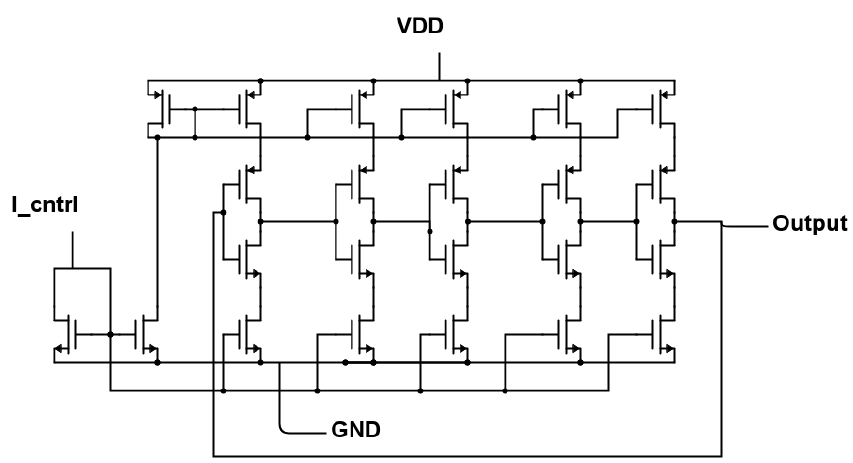
Figure 3. Schematic diagram of the 5-stage current-starved single-ended ring oscillator for receiver and transmitter.